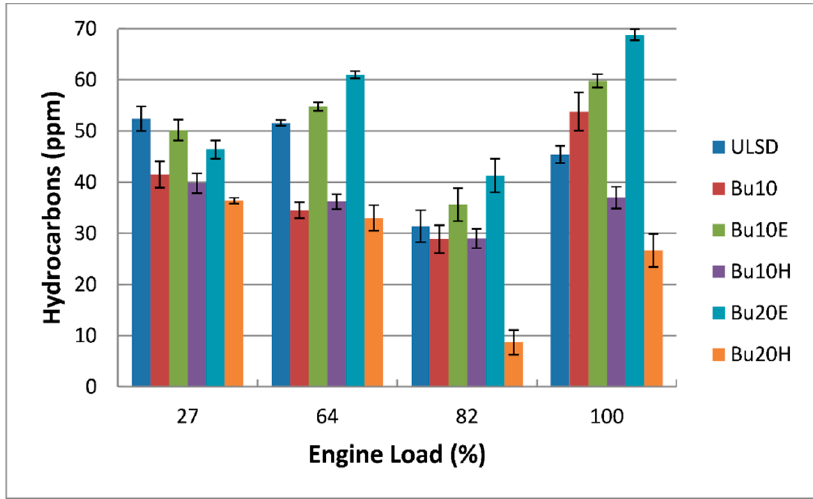
Figure 10. Hydrocarbon emissions of the six fuels with the same DCN.